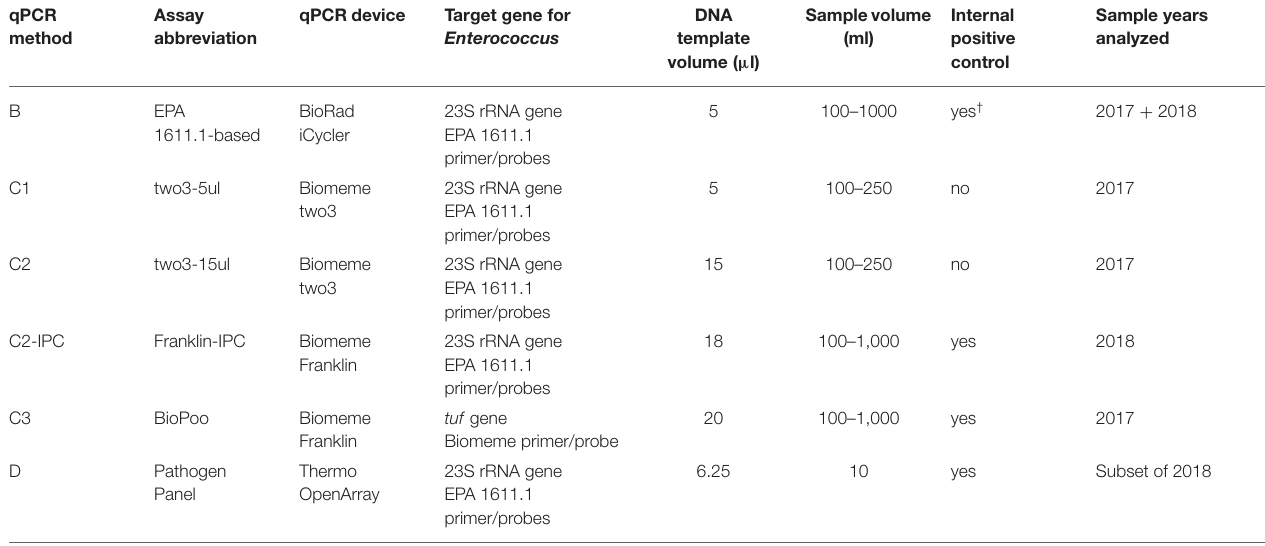
TABLE 1 | Overview of the qPCR methods used in this